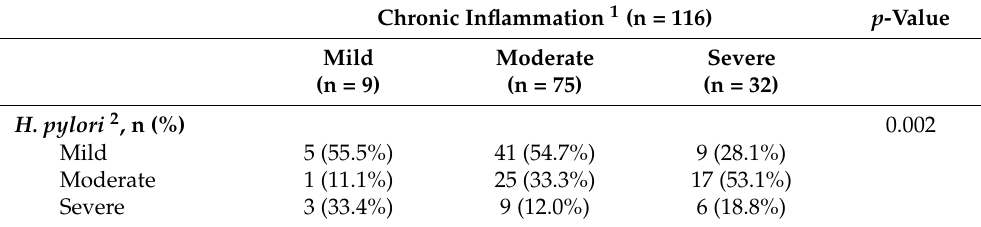
Table 4. The relationship between chronic inflammation and H. pylori